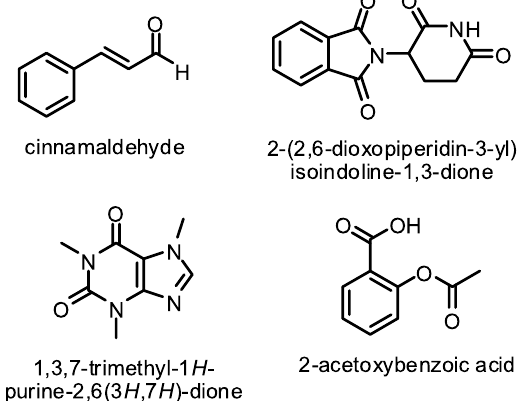
Figure 1. Biologically active materials.